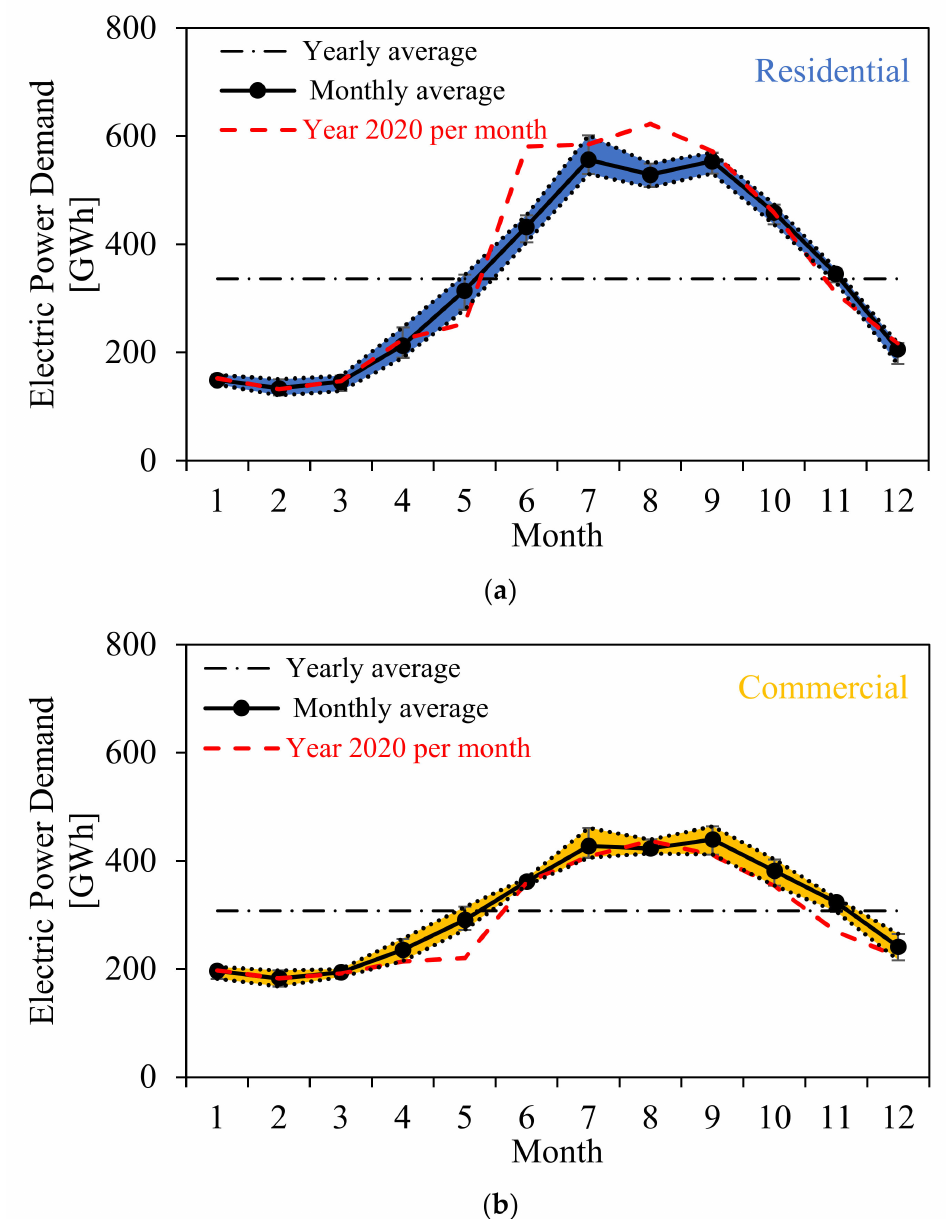
Figure 7. Electric power demand between 2016 and 2019 and an analysis of the demand in 2020 in comparison to the previously reported years for ( a ) residential and ( b ) commercial